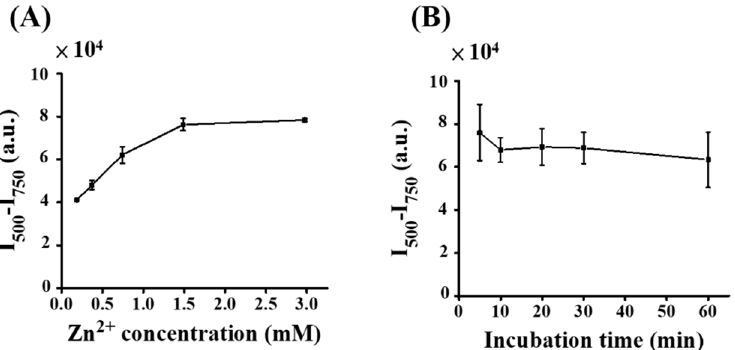
Figure 4. ( A ) Examination of the concentration of Zn 2+ . Graph obtained by plotting the fluorescence intensity difference at the wavelength of 500 to 750 nm (I 500 –I 750 ) of the samples containing TC (0.1 μ M, 300 μ L) versus the concentration of Zn 2+ . Three replicates were conducted. ( B ) Examination of incubation time. Graph obtained by plotting the fluorescence intensity difference at the wavelength of 500 to 750 nm (I 500 –I 750 ) of the samples containing TC (0.1 μ M, 300 μ L) with the addition of Zn 2+ (1.49 mM) at pH 9 versus incubation time. Three replicates were conducted.